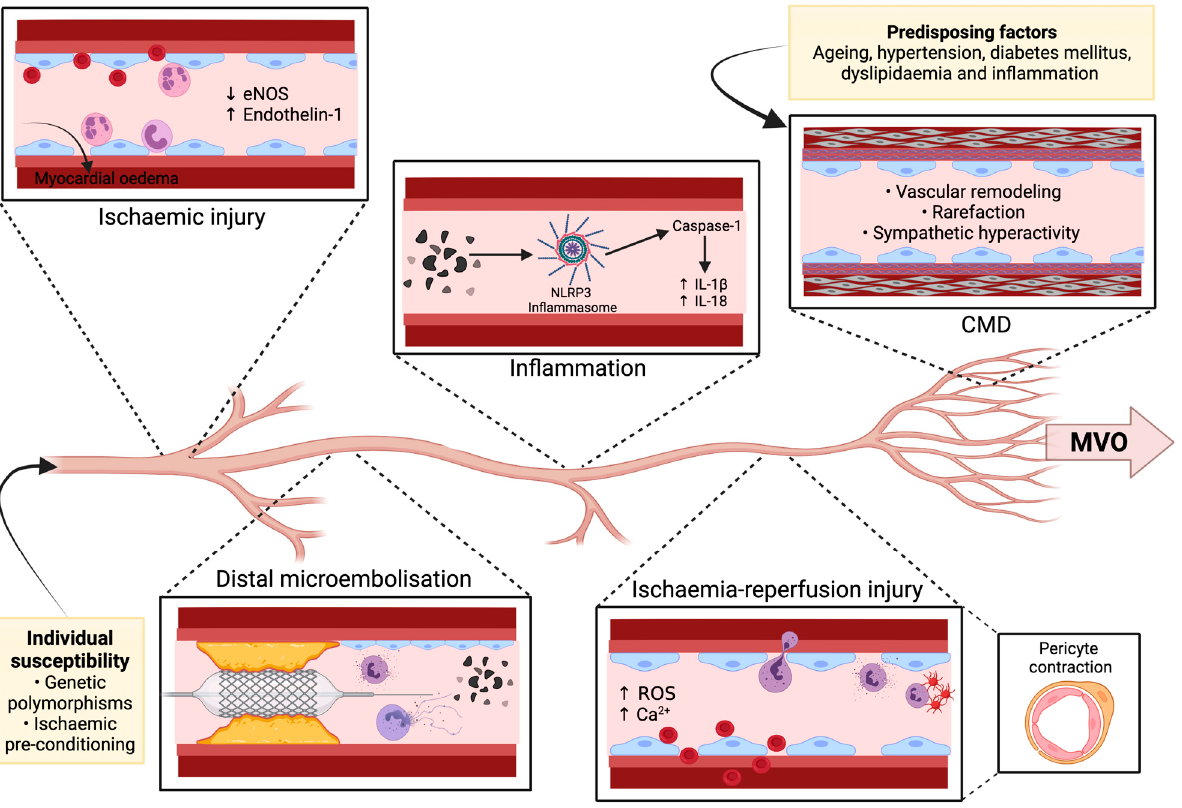
Figure 1. Pathophysiology of MVO. Various genetic polymorphisms and the absence of ischaemic pre-conditioning predispose coronary microcirculation to injury. Plaque disruption, whether spontaneous or PCI-induced, results in distal microembolisation of cellular debris and augmentation of the inflammatory cascade, particularly neutrophil activation. Ischaemic injury to the microcirculation causes endothelial damage and extravasation of erythrocytes and inflammatory cells, resulting in myocardial oedema and luminal narrowing. Moreover, ischaemic injury promotes vasoconstriction by decreasing eNOS release and increasing endothelin-1 release, further limiting microvascular flow. Triggered by inflammatory debris, the NLRP3 inflammasome activates caspase-1 thereby mediating the cleavage of proIL-1b and proIL-18 into